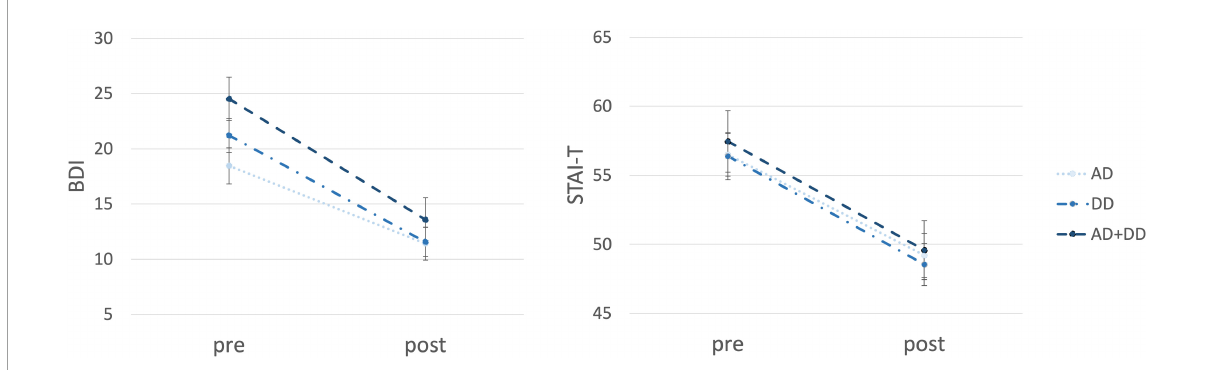
FIGURE2 Changes in depressive and anxious symptoms for patients across treatment. On the y -axis the symptom severity (BDI/STAI-T) and on the x -axis the time (pre/post-treatment) are displayed. The three groups (AD, DD, and AD + DD) are shown by different lines. BDI, beck depression inventory; STAI-T, state-trait anxiety inventory trait subscale; AD, anxiety disorder; DD, depressive disorder; AD + DD, comorbidity. A total BDI score of 0–9 is considered not depressed, 10–18 indicates mild-moderate depression, 19–29 indicates moderate-severe depression, and 30–63 indicates severe depression. The total STAI-T score varies from 20 to 80. A low score indicates a low level of anxiety and a high score indicates a high level of anxiety. STAI scores of 20–37 are classified as “no or low anxiety,” of 38–44 as “moderate anxiety,” and of 45–80 as “high